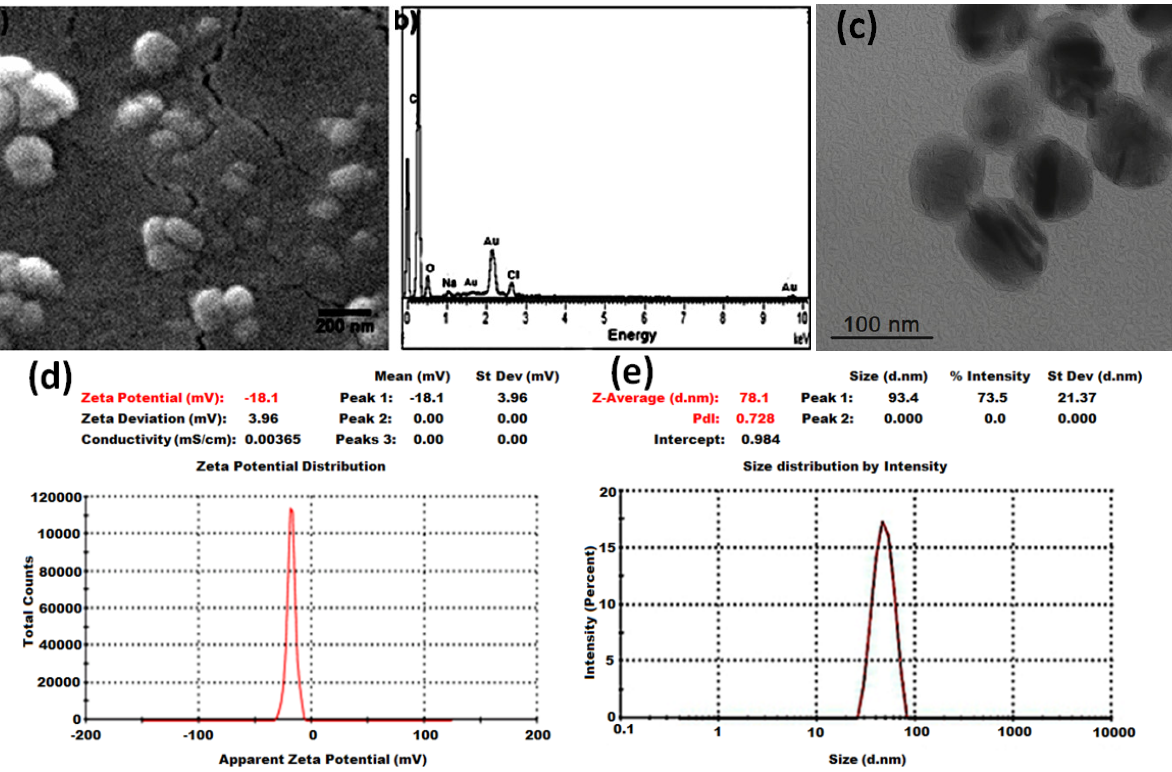
Figure 2. SEM and TEM of REEW-GNs showing spherical morphology ( a , c ) and EDX spectrum of REEW-GNs illustrating the elemental composition of the sample ( b ). Zeta potential of − 18.1 mV ( d ) and average hydrodynamic diameter of 78.1 nm ( e ) of colloidal REEW-GNs are shown. The X-ray diffraction (XRD) analysis of REEW-GNs exhibited distinct peaks at 2 θ values 38.24 ◦ , 44.50 ◦ , 64.7 ◦ , 77.80 ◦ , and 77.92 ◦ , which corresponded to Bragg’s planes (1 1 1), (2 0 0), (2 2 0), and (3 1 1) of gold, respectively. The diffraction pattern of GNs was in